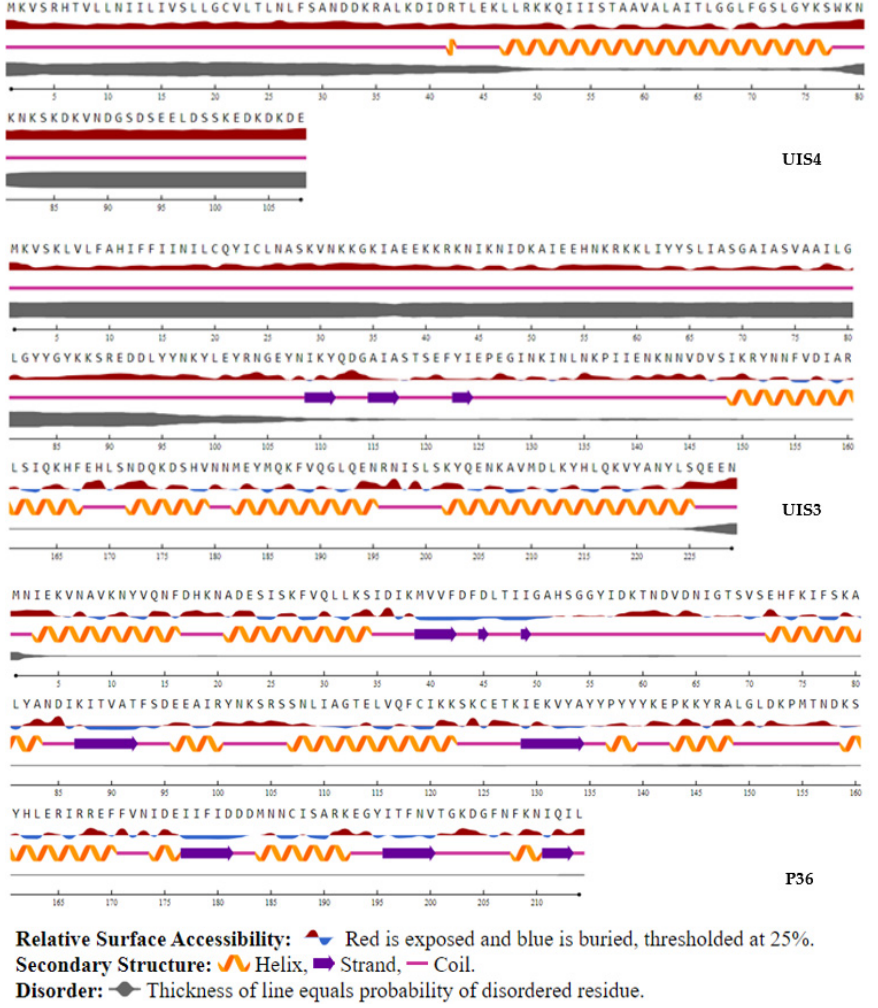
Figure 3. Predicted secondary structure and surface accessibility of P36, UIS3, and UIS4 malaria vaccine candidates. Table 2. Relative surface accessibility of putative CD4+ and CD8+ T-cell